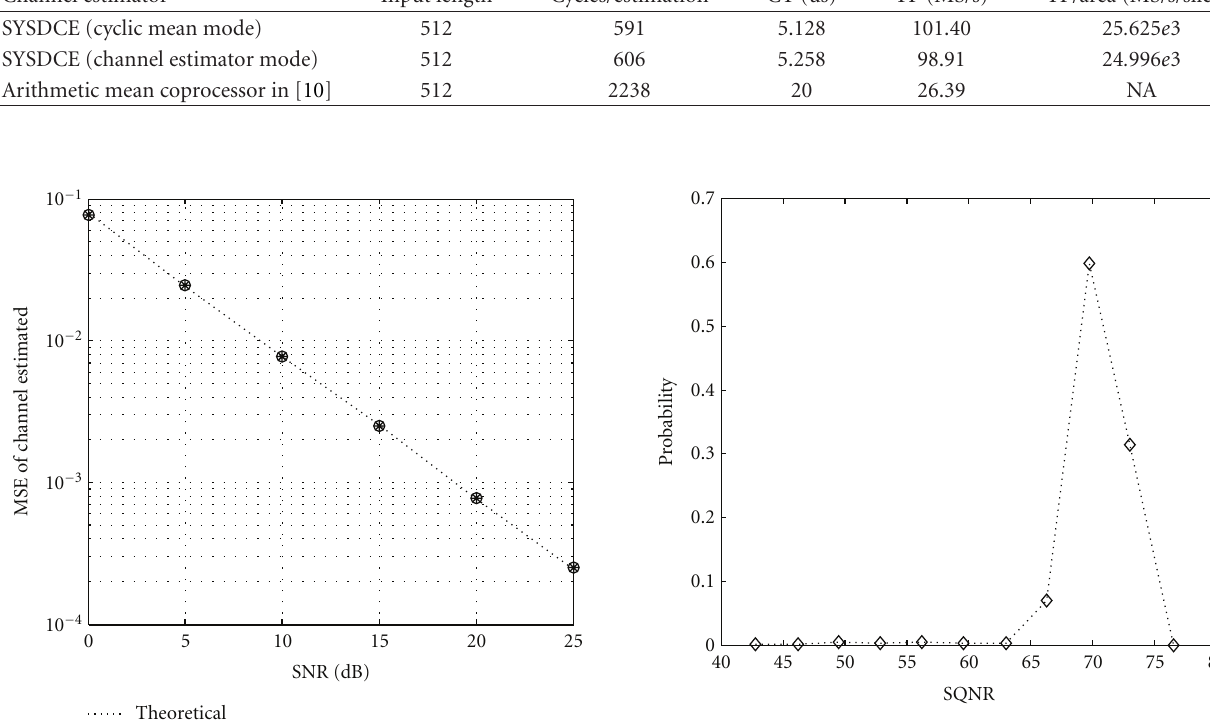
Figure 15: SQNR probability density function of SYSDCE architec- ture for 300 Monte Carlo